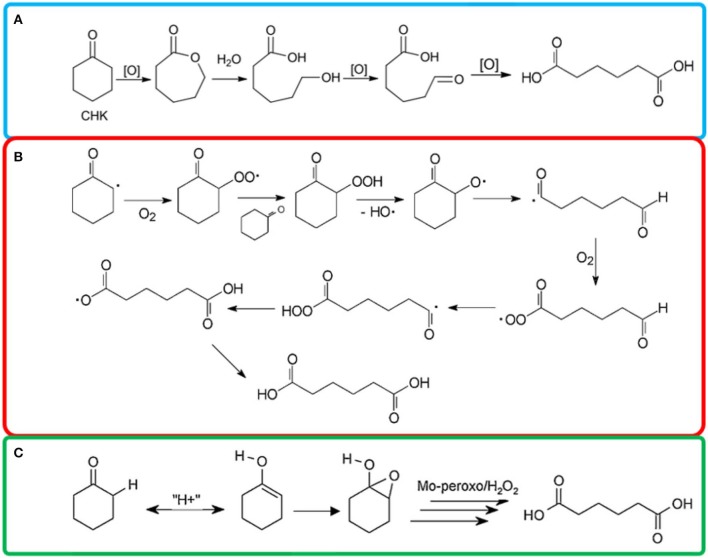
Proposed (A) Baeyer-Villiger oxidation type of mechanism, (Pisk et al., 2019) (B) radical chain autoxidation mechanism, (Cavani et al., 2011) (C) redox mechanism (Amitouche et al., 2018) of cyclohexanone oxidation to AA.